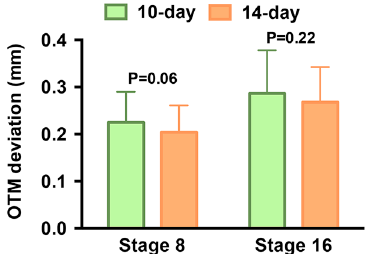
Figure 5. Shell-to-shell deviation of OTM (mean ± standard error) at Stage 8 (T1) and Stage 16 (T2) of the Invisalign treatment. There was no statisti- cally significant difference between the 10-day group and 14-day group.